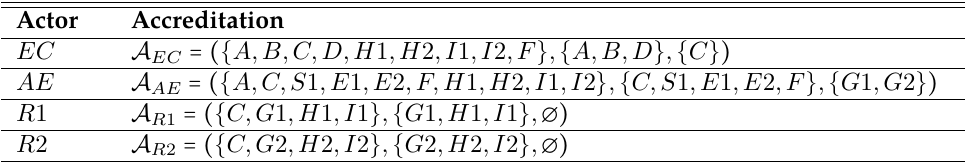
Table 1: Accreditations of the different actors taking part in the peer-review process.